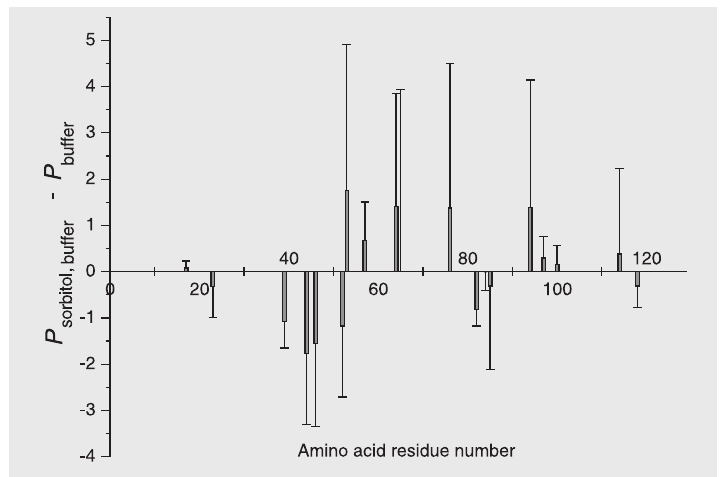
Figure 3. Difference in P -factors, ∆ P = P sorbitol, buffer - P buffer , between heat-induced denatured state in the presence and absence of 500 mM sorbitol as a function of amino acid residue number. Within the accuracy of the experiment, the addition of 500 mM sorbitol led to no significant change of P -factors.